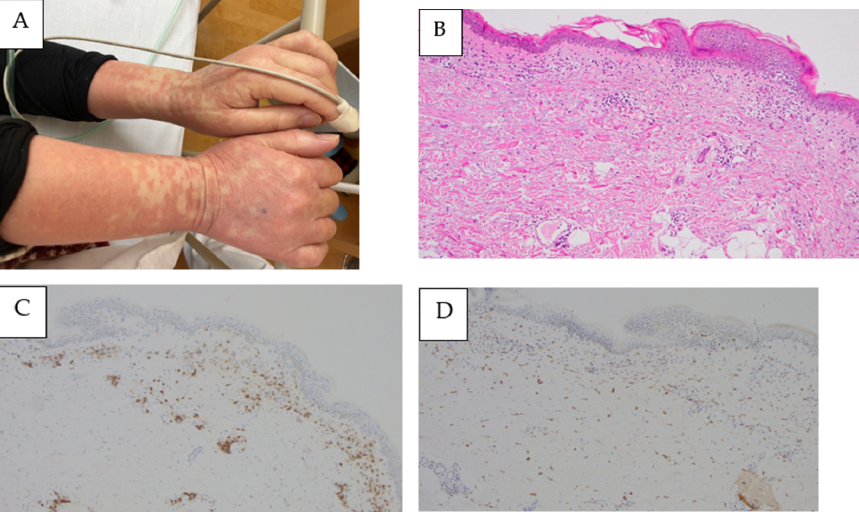
Figure 3. ( A ) Pruritic erythema on both forearms. Skin biopsy on day 7 of admission indicates: ( B ) small vessels dilated in the papillary dermis with edema by hematoxylin and eosin staining. Magnification ×100; ( C ) perivascular infiltration of plasma cells by CD38 staining. Magnification ×100; ( D ) perivascular infiltration of histiocytes by CD68 staining. Magnification ×100.